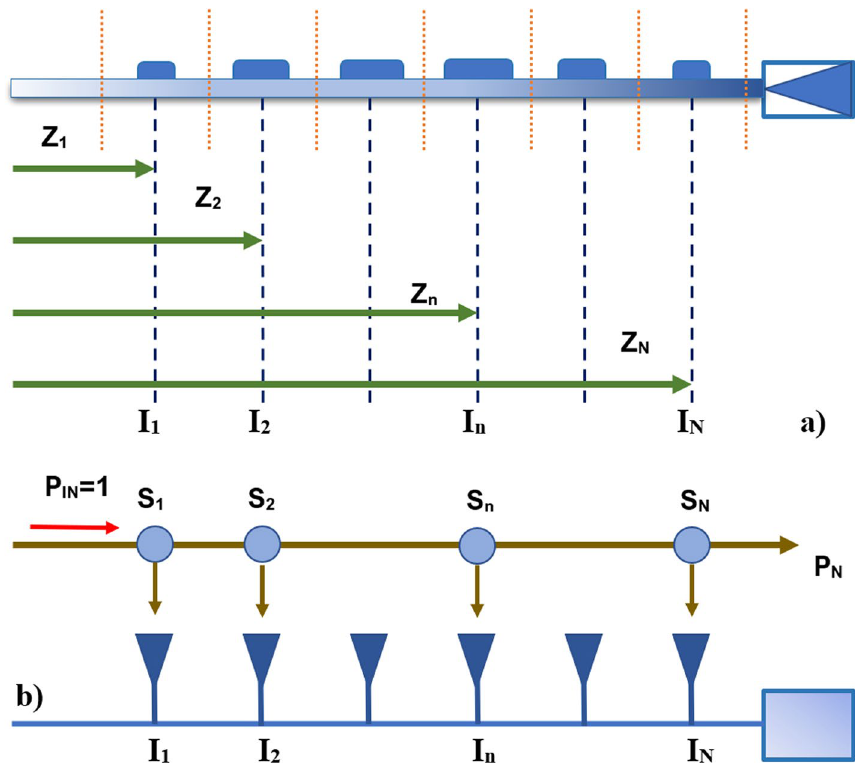
Fig. 1 Antenna array model: a current distribution of the antenna array model; b The power coupling coefficients of the k-th array